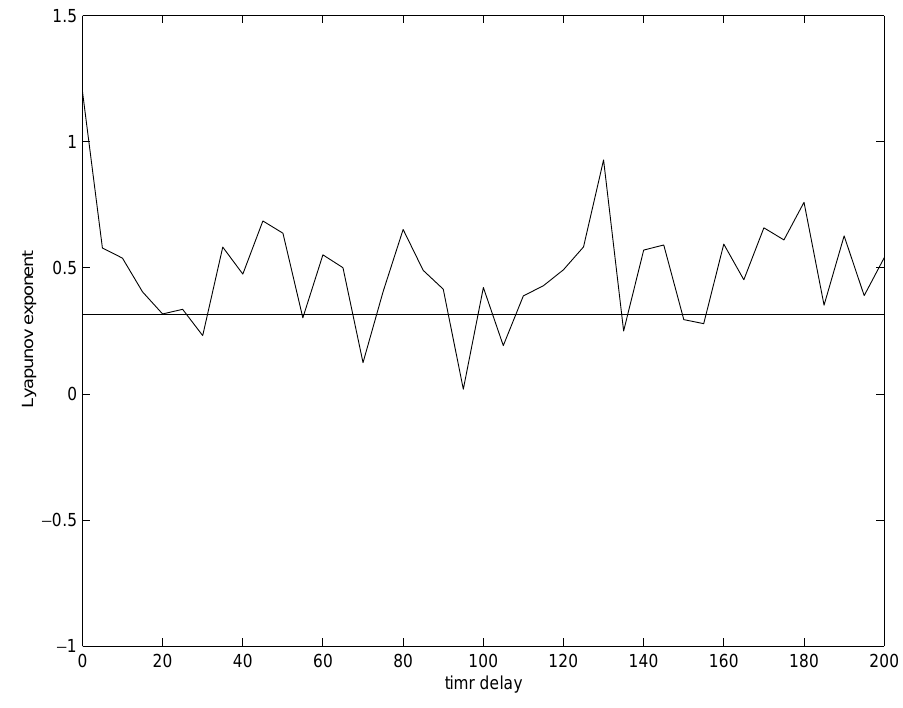
Fig. 13. Evolution of the Lyapunov exponent with respect to time delay with low pass filtering.